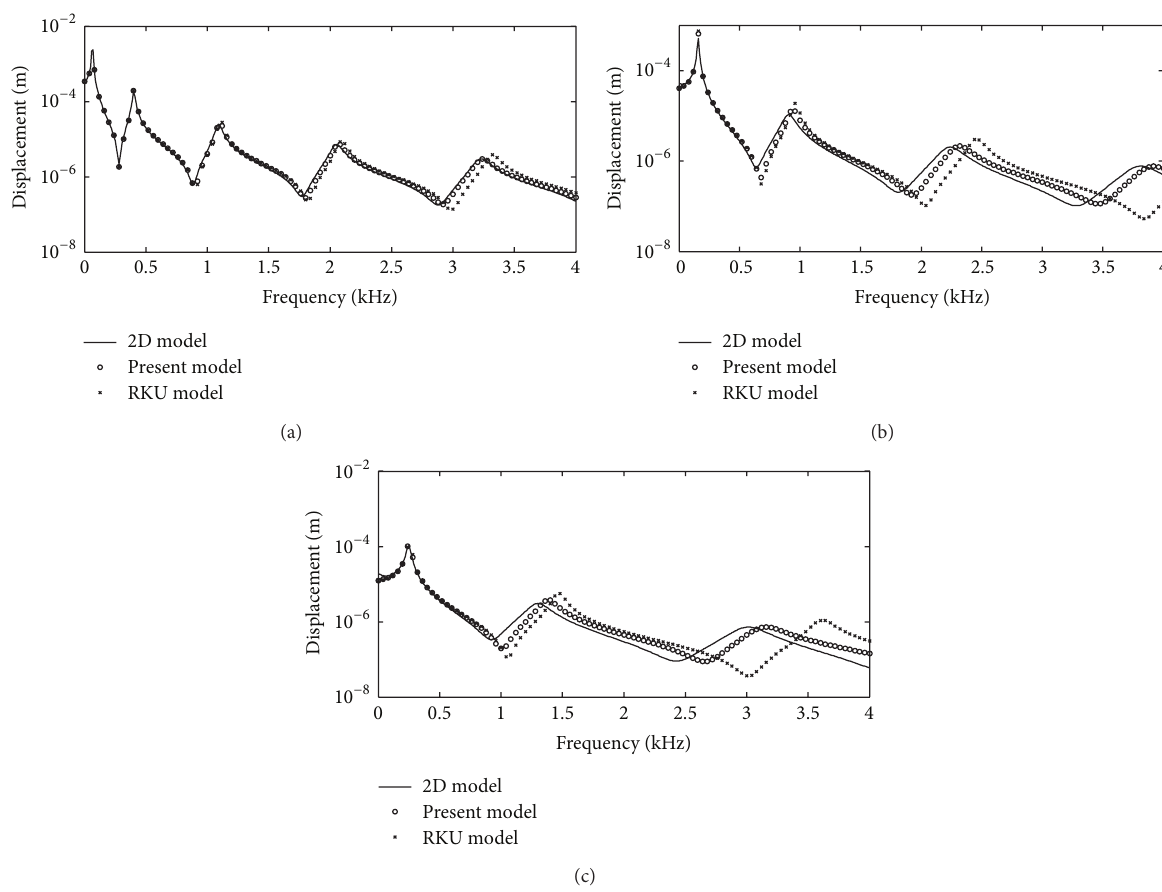
Figure 4: Frequency response function for the free-end for the cantilever beam: (a) 𝐻 2 = 1 mm, (b) 𝐻 2 = 5 mm, and (c) 𝐻 2 = 10 mm.